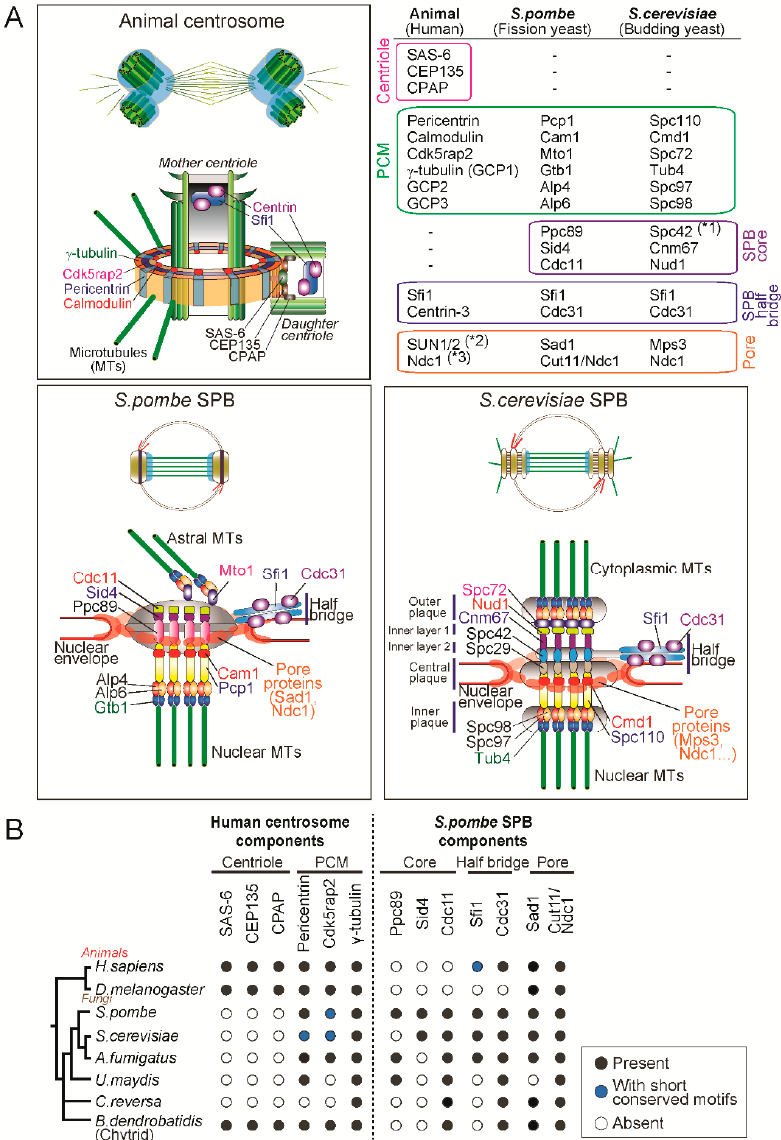
Figure 2. The molecular components of animal centrosomes and yeast SPBs. ( A ) Mapping of molecular components in the animal centrosome and budding and fission yeast SPBs. (*1. Spc42 seems functionally analogous to Ppc89 [61], *2,3. The protein is conserved but not known to be implicated in centrosome functions.) The illustrated SPB structure was adapted and modified from [13]. ( B ) Phylogenetic distribution of centrosome components in animals and fungi. We searched for orthologues of components of the human centrosome localizing to centrioles and PCM and the fission yeast SPB components by using reciprocal pairwise sequence-based (BLASTP and phmmer) and domain-based (hmmsearch) methods [87,88]. Black circles represent the presence of orthologues; blue circles indicate that previous studies showed the presence of a protein with short conserved motifs [47,56,60] although we failed to identify it by the above-mentioned computational methods; white circles indicate no detectable orthologue ([89] and our unpublished